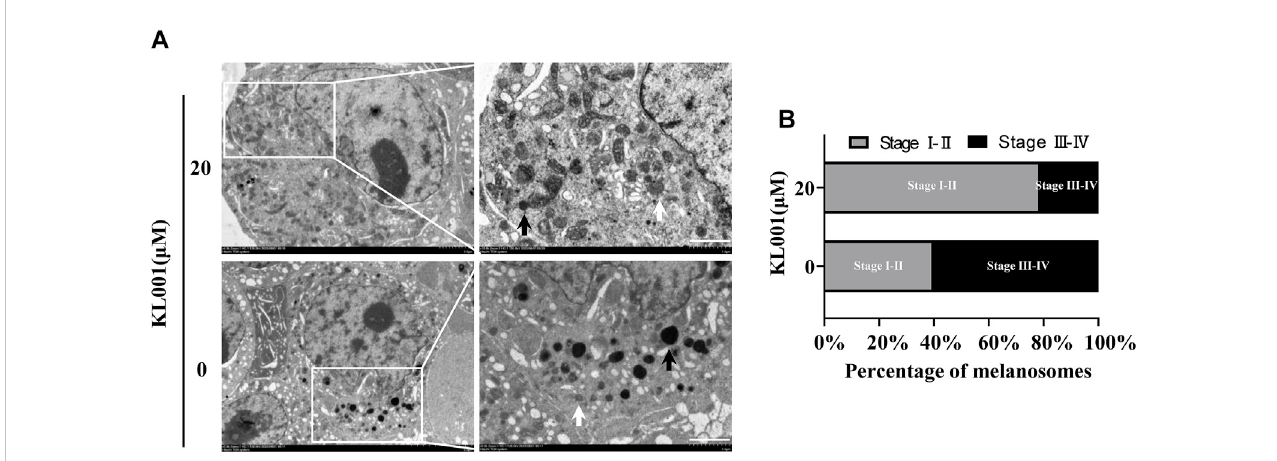
FIGURE 2 KL001inhibitedmelanosomematuration. (A) B16F10cellsunderTEMafter48 hinthepresenceofKL001.Thewhitearrowandtheblackarrowindicated